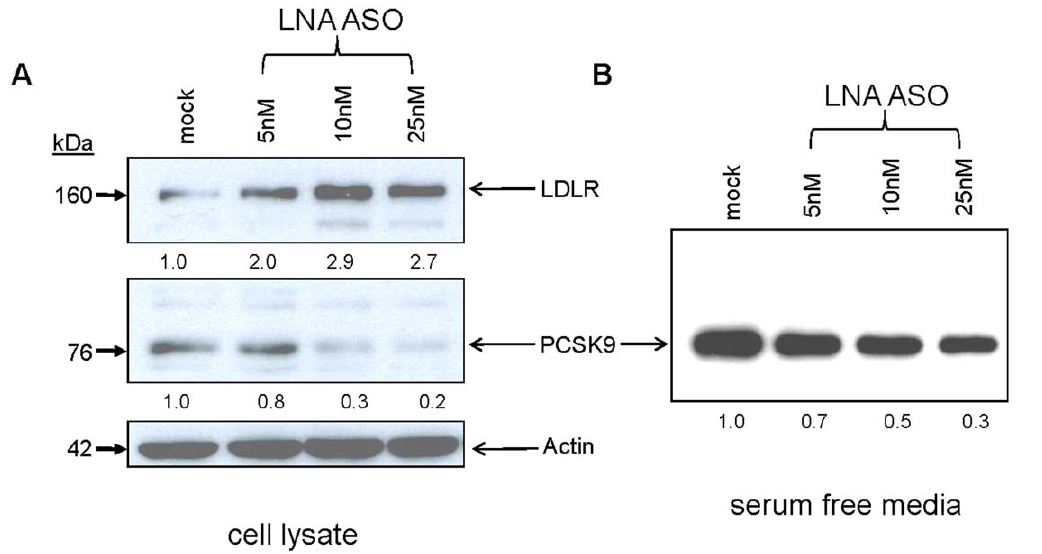
Figure 4. Reduction in the levels PCSK9 protein by LNA ASO is accompanied by an increase in LDLR protein expression. HepG2 cells were transfected with 5, 10 and 25 nM LNA ASO (lanes 2–4). For mock, only water was used instead of LNA solution (lane 1). (A) 72h later, cell lysates were analyzed by Western blot for endogenous levels of human PCSK9 along with LDLR protein levels. The protein b -actin was used as a loading control. (B) Western blot analysis of overnight conditioned media of LNA ASO-transfected HepG2 cells, reflecting the levels of secreted